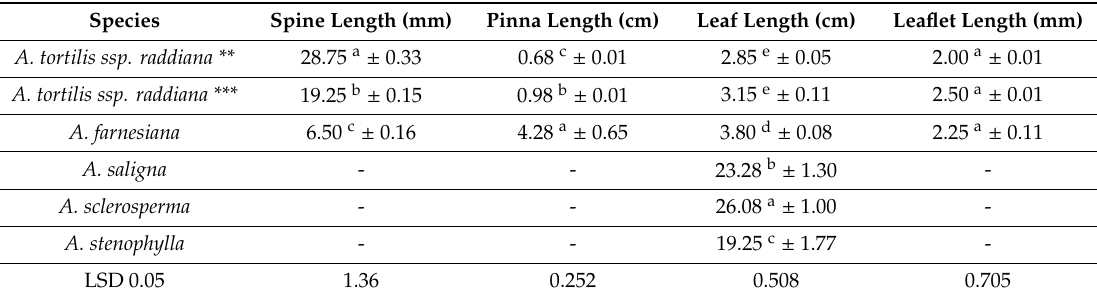
Table 1. Morphological variations of Acacia species: spine length, pinna length, leaf length and leaflet length.